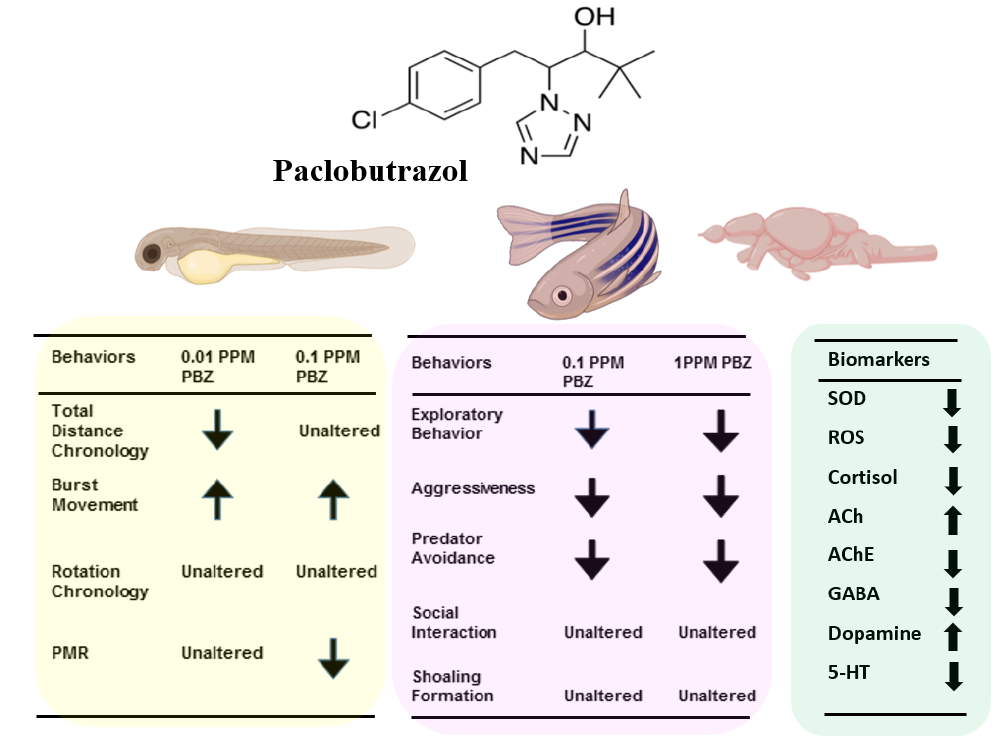
Figure 11. Schematic summary of the behavioral and biochemical alterations in larvae and adult zebrafish after exposed to different doses of Paclobutrazol. The left yellow panel summarizes the behavioral alterations in the larvae stage, middle pink panel summarizes the behavioral alterations in the adult stage, and right green panel summaries the biomarker content in adult brains after exposed to Paclobutrazol.